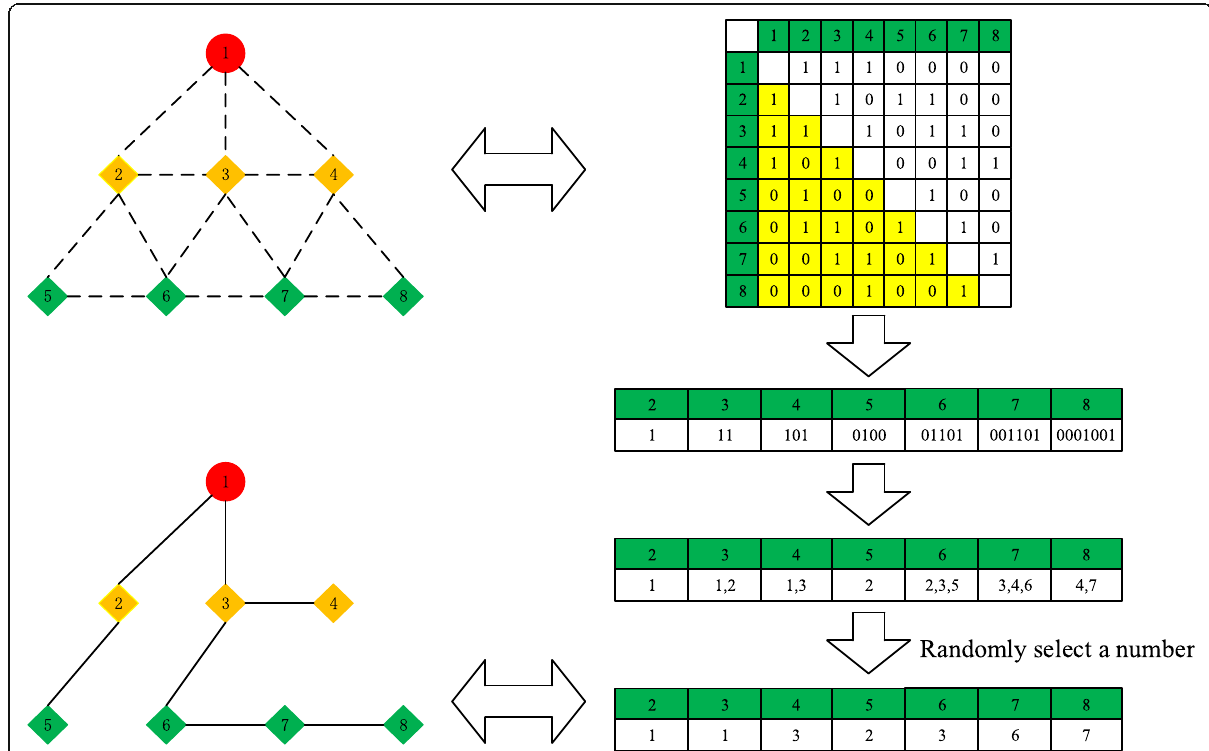
Fig. 5 Particle population initialization. We use the adjacency matrix to generate particles. As shown in Fig. 5, nodes that can communicate with each other are first connected by dashed lines to create an adjacency matrix. Here, 1 indicates a connection state, and 0 indicates a non- connection state. Next, the lower left half of the adjacency matrix is taken out and rewritten as one line as shown in Fig. 5. Finally, particles can be generated by randomly extracting a number from each part